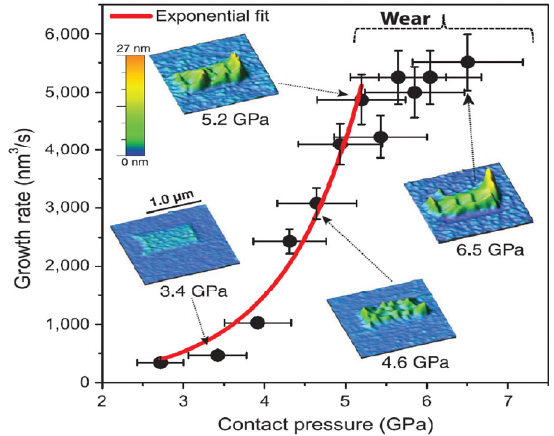
Fig. 13 ZDDP tribofilm growth rate versus contact pressure on a silicon surface. Topography images are after 2,000 cycles. Reproduced with permission from [127]. Copyright Science ASSS,